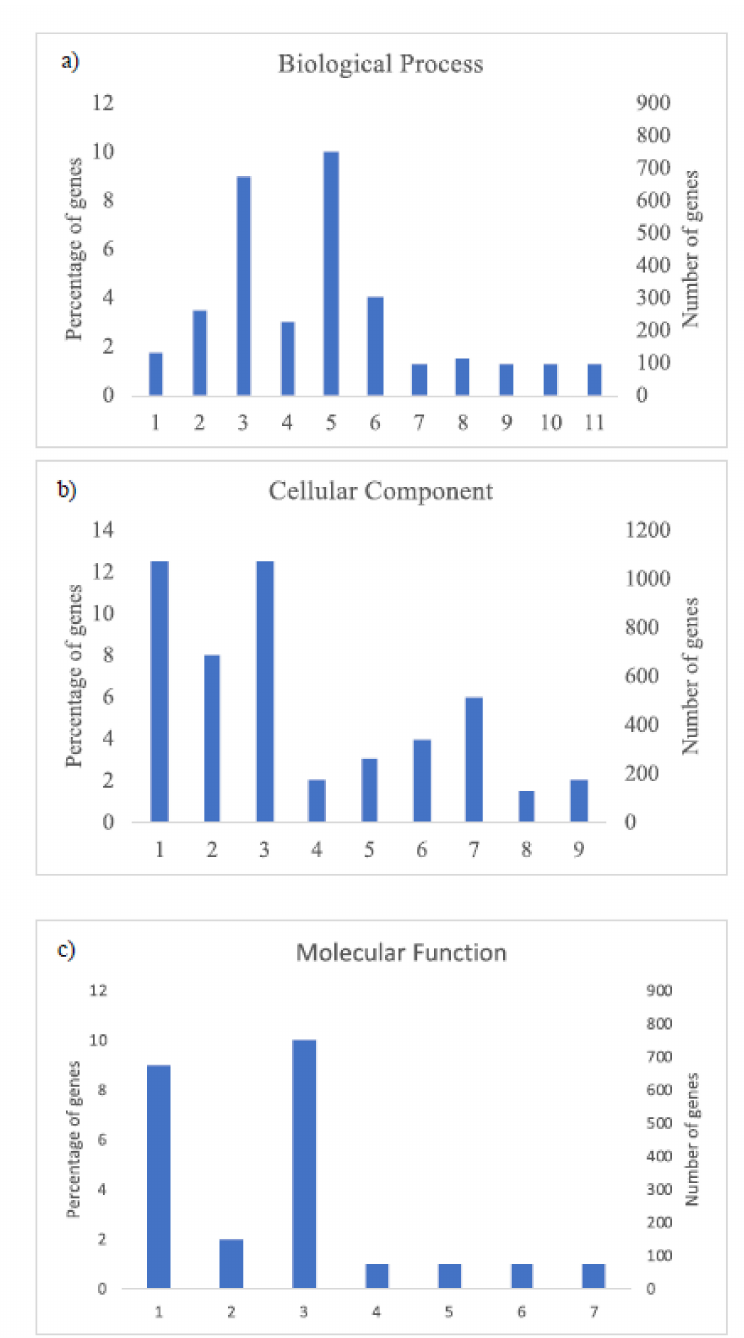
Figure 3. HistogramofGOclassificationsof L.perenne polleninsamplesof2017. Resultsaresummarizedfor thethreemaincategories: ( a )Biologicalprocess: 1. Localization,2. Biologicalregulation,3.Metabolicprocess, 4. Regulation of biological process, 5. Cellular process, 6. Response to stimulus, 7. Multi-organism process, 8. Cellular component organization or biogenesis, 9. Developmental process, 10. Multicellular organismal process, 11. Signaling; ( b ) cellular component: 1. Cell part, 2. Organelle, 3. Cell, 4. Protein-containing complex, 5. Organelle part, 6. Membrane part, 7. Membrane, 8. Membrane-enclosed lumen, 9. Extracellular region; and ( c ) molecular function: 1. Catalytic activity, 2. Transporter activity, 3. Binding, 4. Signal transducer activity, 5. Structural molecule activity, 6. Molecular function regulator, 7. Transcription regulator